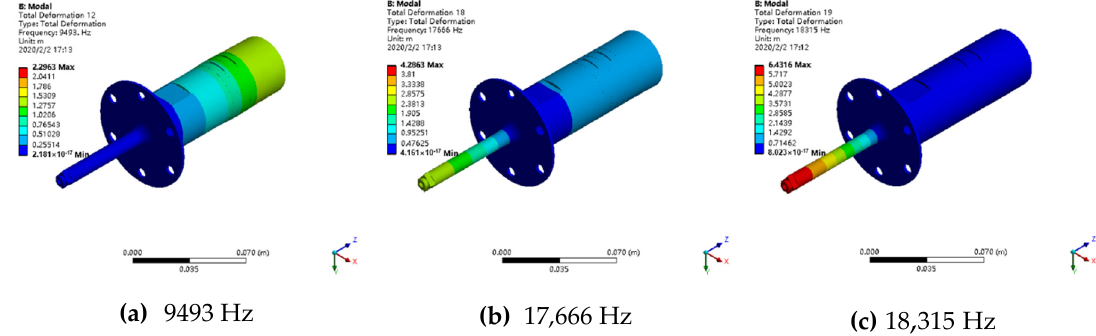
Figure 4. Modal shape of the first three longitudinal vibrations. ( a ) 9493 Hz; ( b ) 17,666 Hz; ( c ) 18,315 Hz.